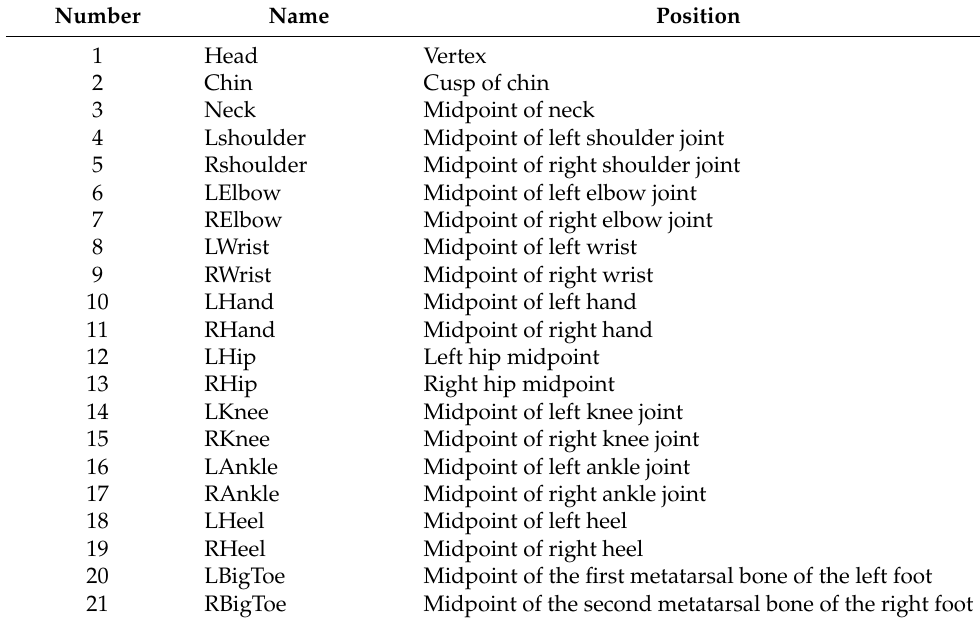
Table 2. Locations of landmark points of 3D reconstruction